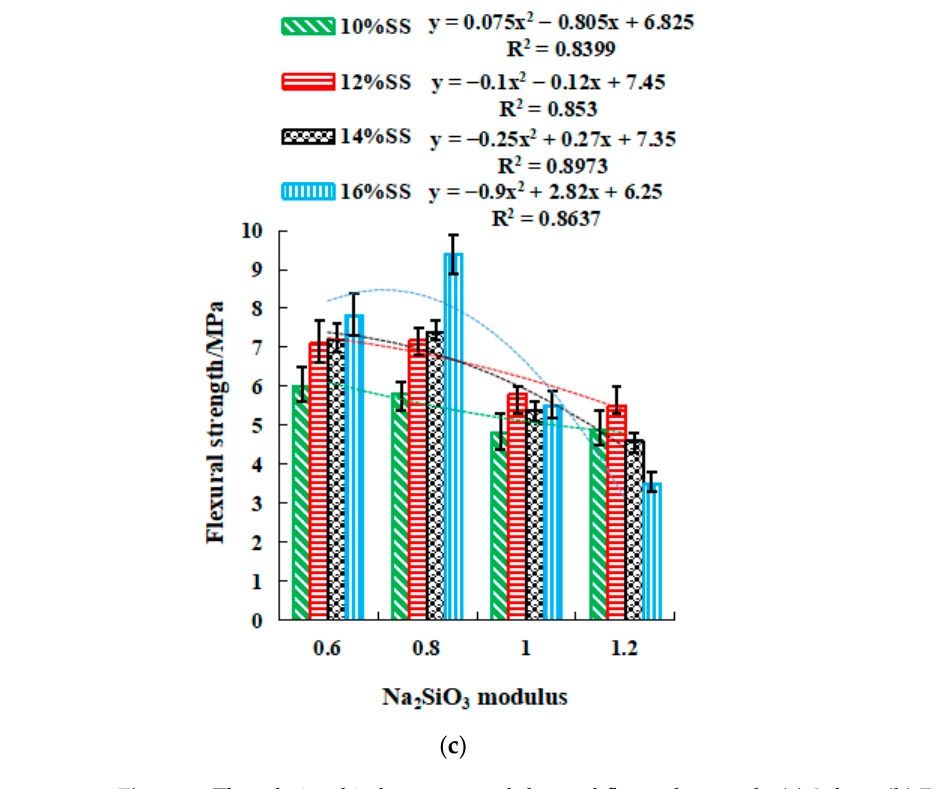
Figure 9. The relationship between modulus and flexural strength. ( a ) 3 days, ( b ) 7 days, ( c ) 28 days. y = ax 2 + bx + c, where y is the compressive or flexural strength, MPa. x is the Na 2 SiO 3 modulus, and 0.6 ≤ x ≤ 1.2, mol L − 1 . a, b, and c are coefficients.